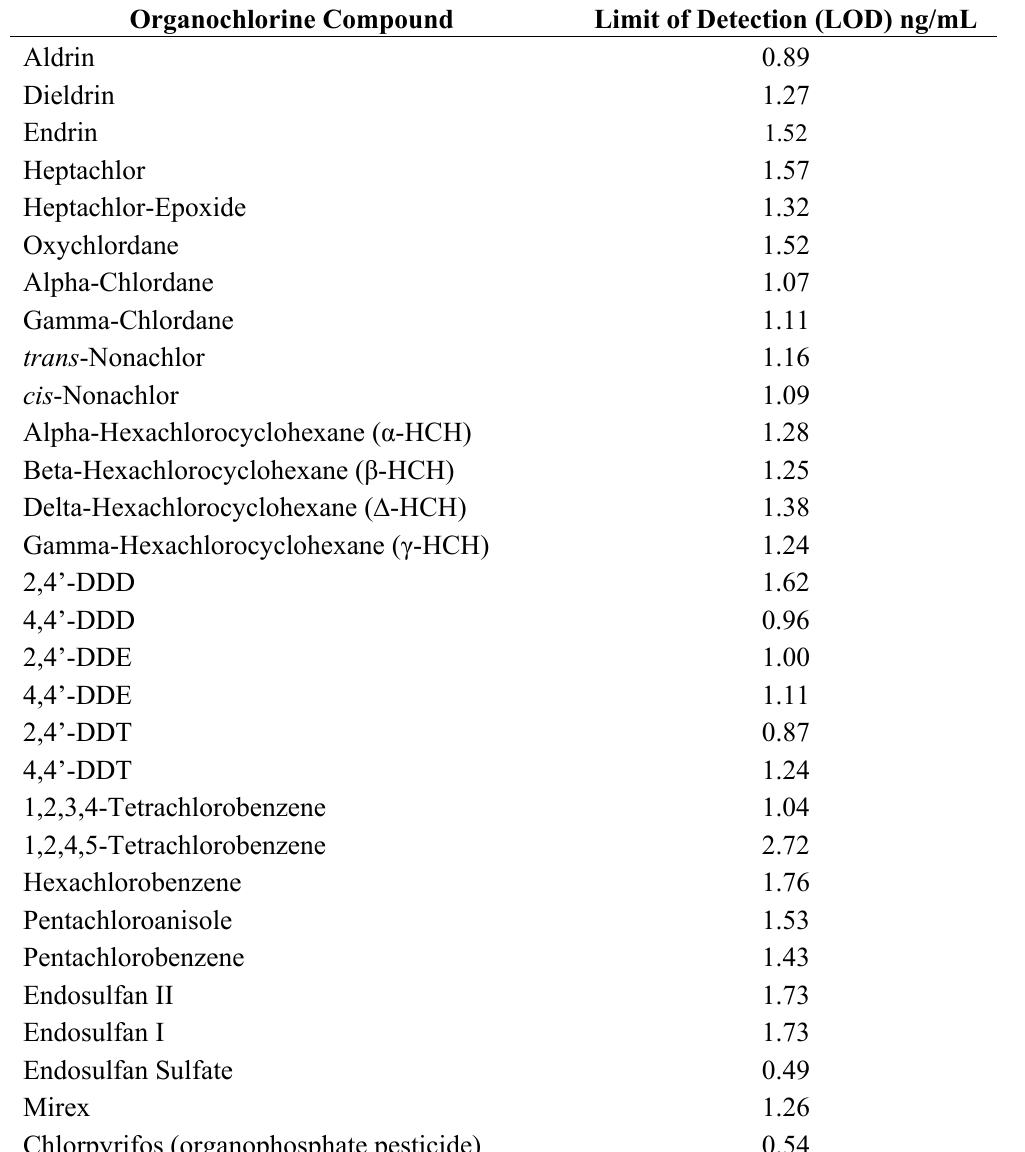
Table A1. Limits of detection (LOD) for 30 organochlorine compounds examined in cord and maternal blood